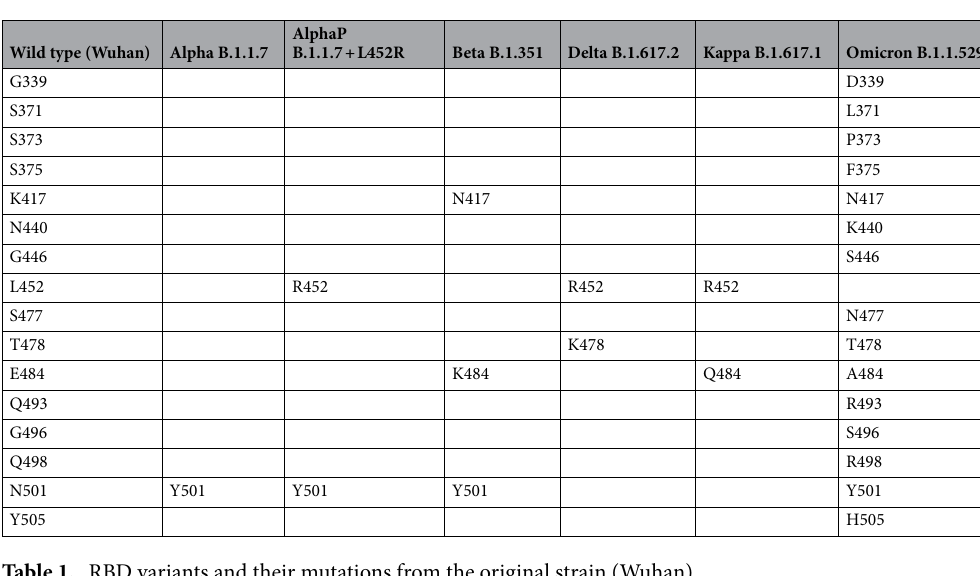
Table 1. RBD variants and their mutations from the original strain (Wuhan).